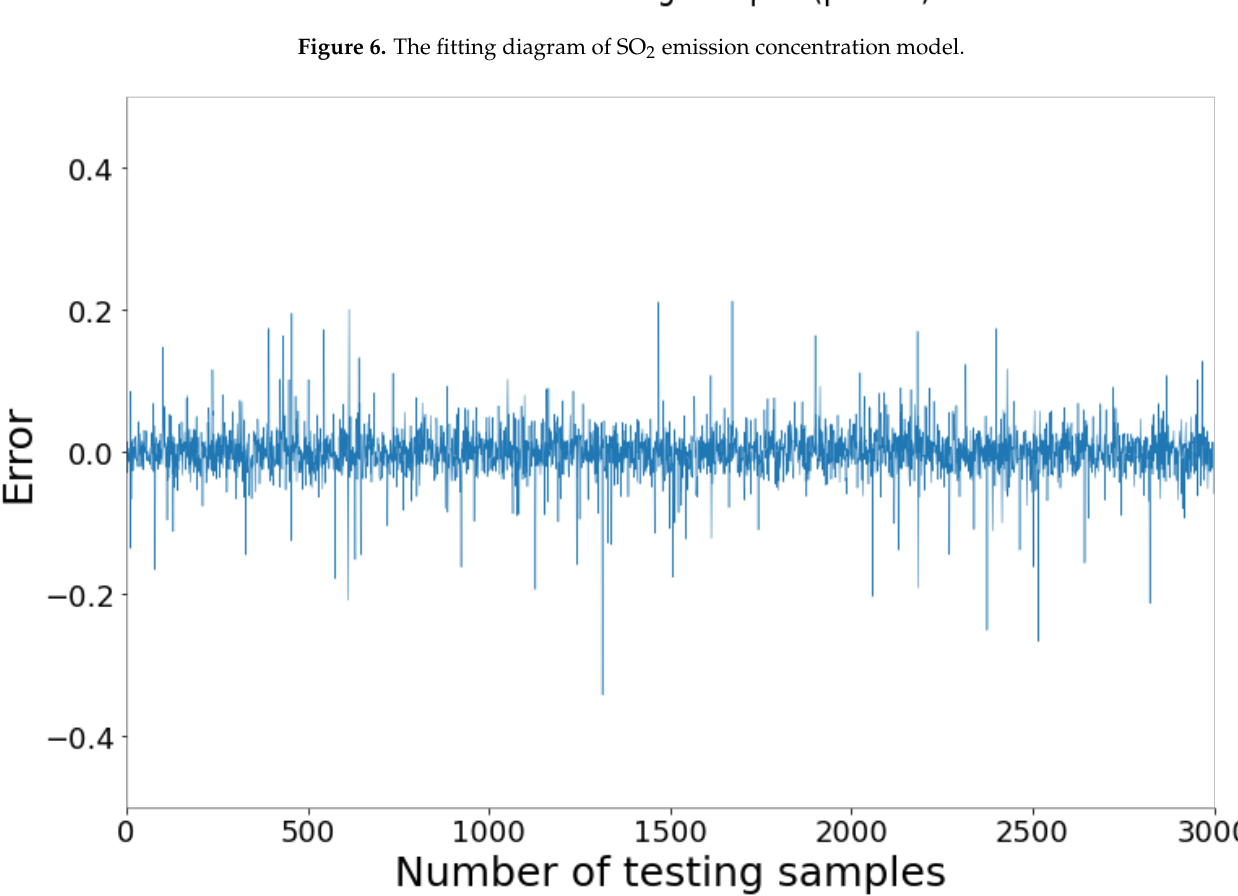
Figure 7. The error diagram of SO 2 emission concentration model.